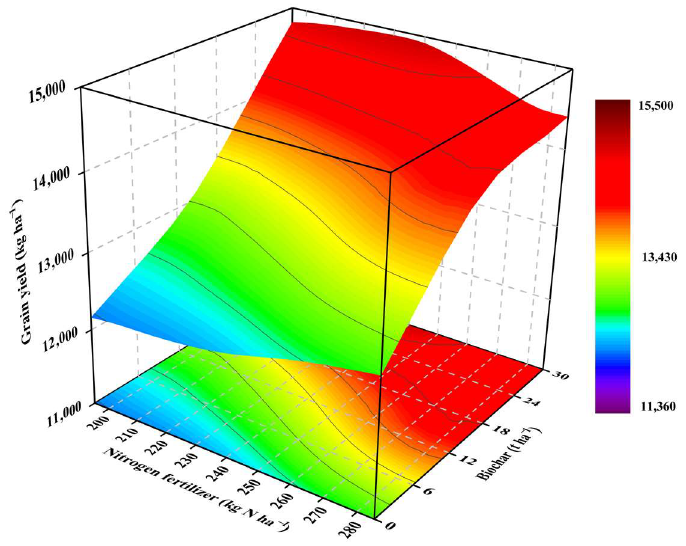
Figure 8. Relationship between maize yield and biochar-fertilizer N application rates in 3D color map surface image.